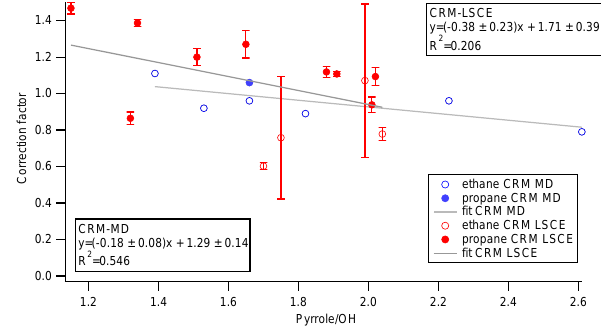
Figure 6. Correction factor of reactivity for the kinetics regime re- ported vs. pyrrole-to-OH ratio in the reactors. Correction for CRM- LSCE is represented in red while correction for CRM-MD is repre- sented in blue. Full circles refer to the experiments conducted with propane while hollow circles refer to the experiments with ethane as gas standard. Linear fits include coefficient values ± 1 σ